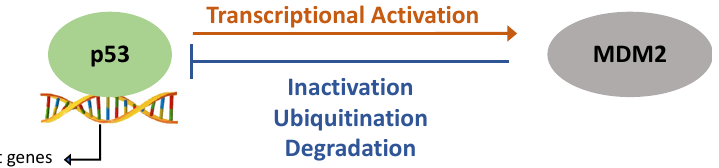
Figure 1. p53 and mouse double minute-2 (MDM2) auto-feedback loop. DNA damage and cellular stress increase p53 expression and facilitate its nuclear import. This allows for p53’s transcriptional activation of target genes, including MDM2. p53-induced MDM2 activation then results in p53 binding to MDM2 and its proteasomal degradation.